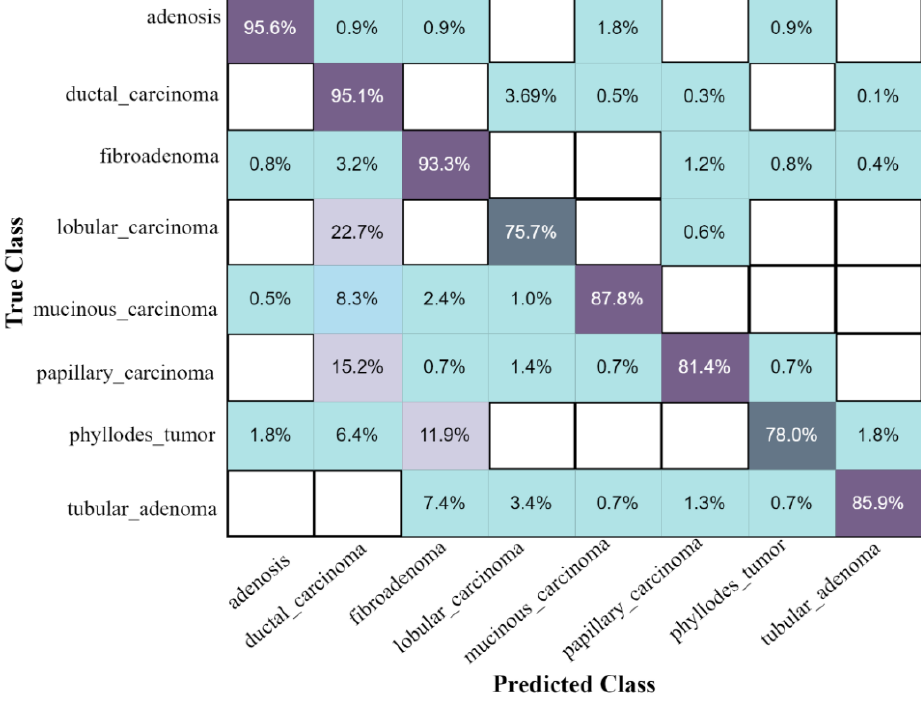
Figure 4. The confusion matrix results of the proposed method on the BreaKHis dataset, with ESKNN classifier using the 10-fold validation.